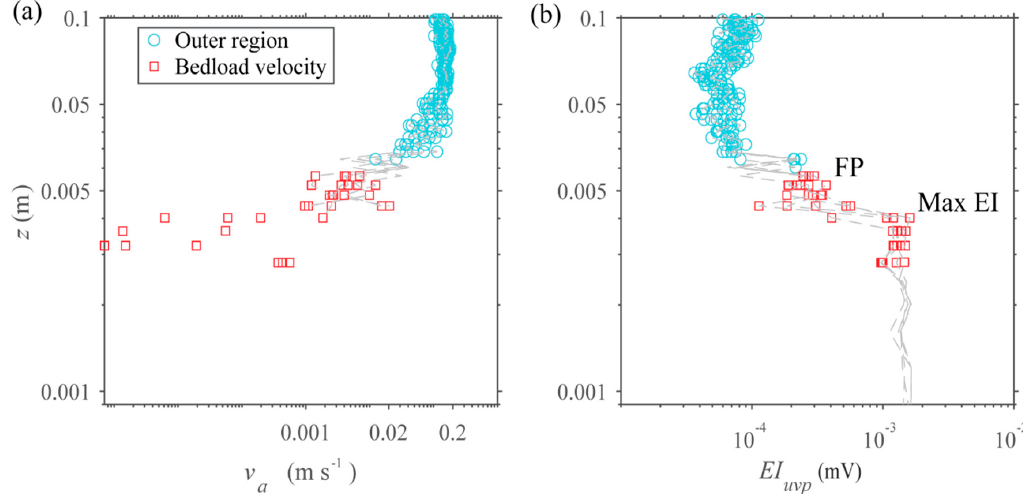
Figure 3. ( a ) Full velocity profile of UVP at 1.5 MHz, θ = 25°; ( b ) echo intensity profile of UVP at 1.5 MHz, θ = 25°.